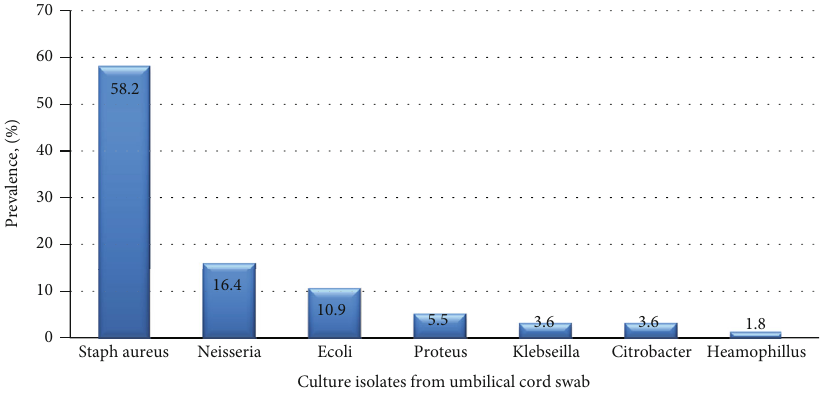
Figure 1: Bar graph showing the percentage prevalence of bacteria causing omphalitis among neonates. Table 2: Percentage antibiotic susceptibility patterns of bacterial isolates from cord swabs of neonates diagnosed of omphalitis.